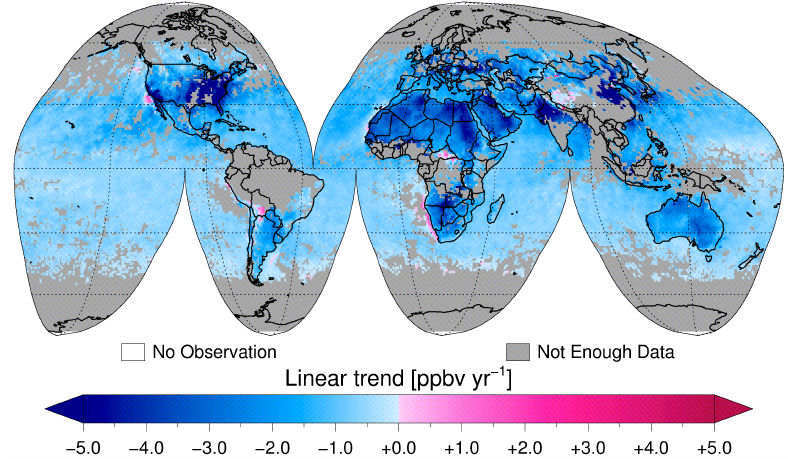
Fig. 2. The linear trends of surface CO from MOPITT (Version 5 TIR, Level 3, daytime) from 2001 to 2010. “Not Enough Data” represents the data series discarded to avoid statistical inconsistencies. Complete yearly data sets encompass at least nine months of data over the year.